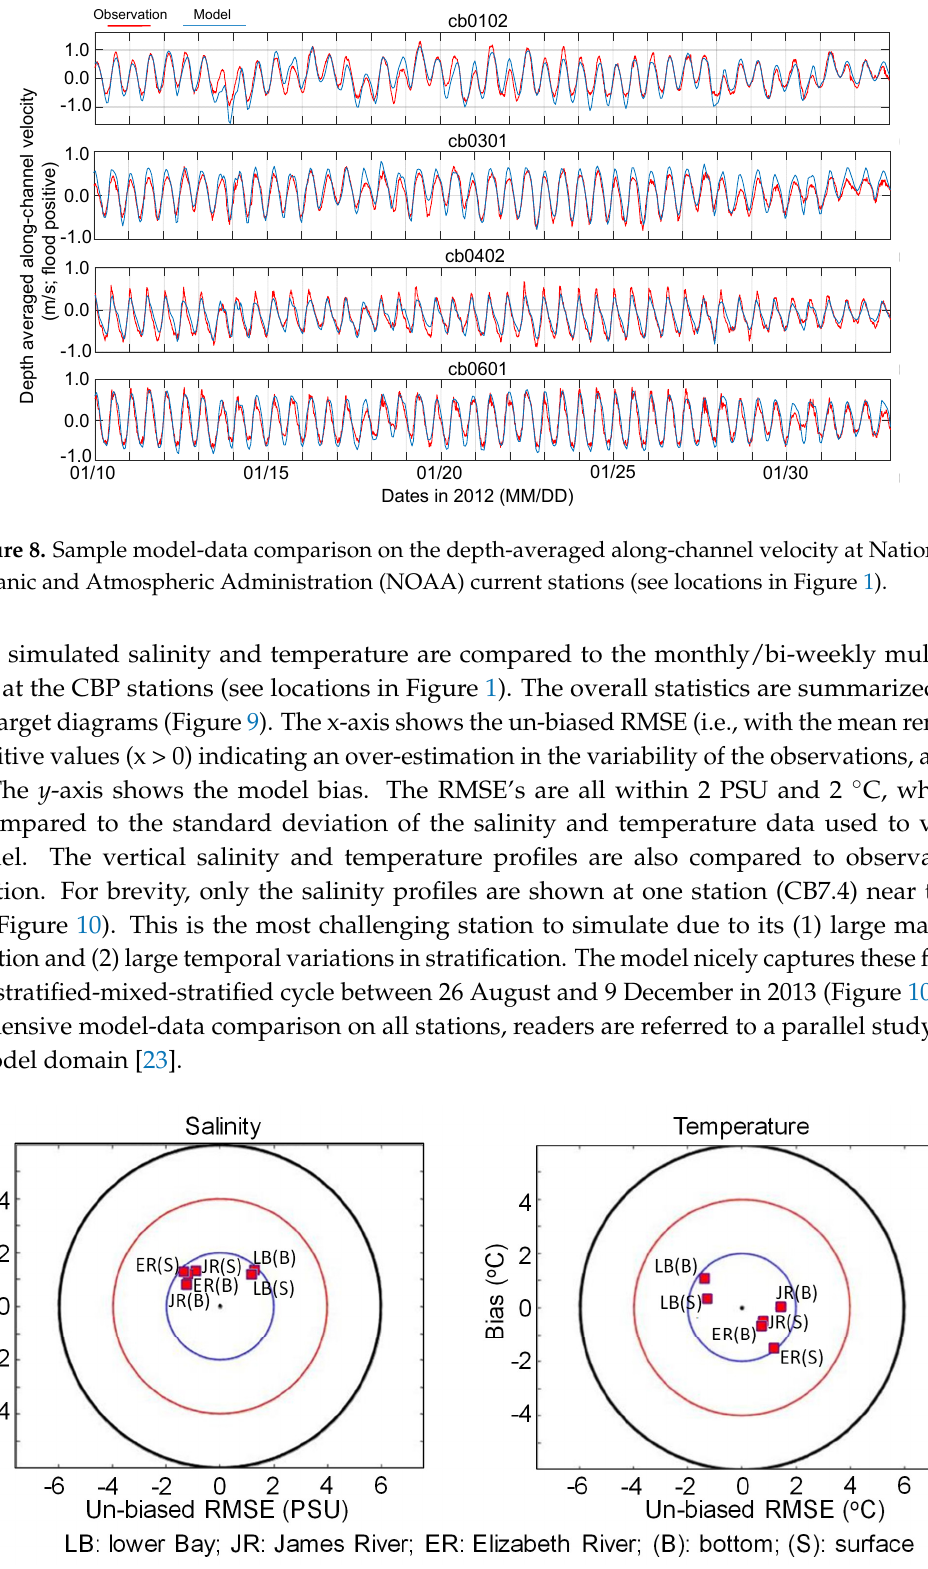
Figure 9. Overall statistics of the model skills on salinity and